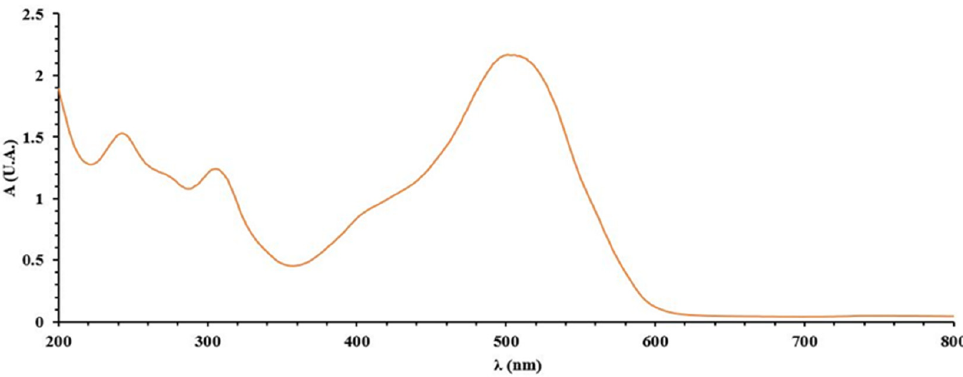
Figure 1. Representation of UV-Vis spectra for 60 mg/L DR 23.